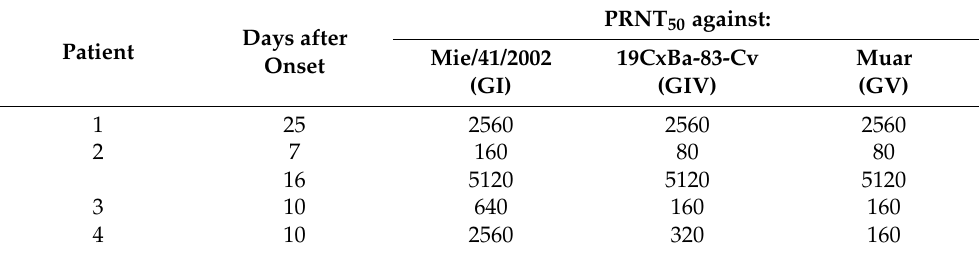
Table 3. Neutralization titers (PRNT 50 ) in sera from GI JEV-infected JE patients against JEV strains Mie/41/2002, 19CxBa-83-Cv, and Muar 1 . PRNT 50 against: Days after Patient Mie/41/2002 Onset (GI)